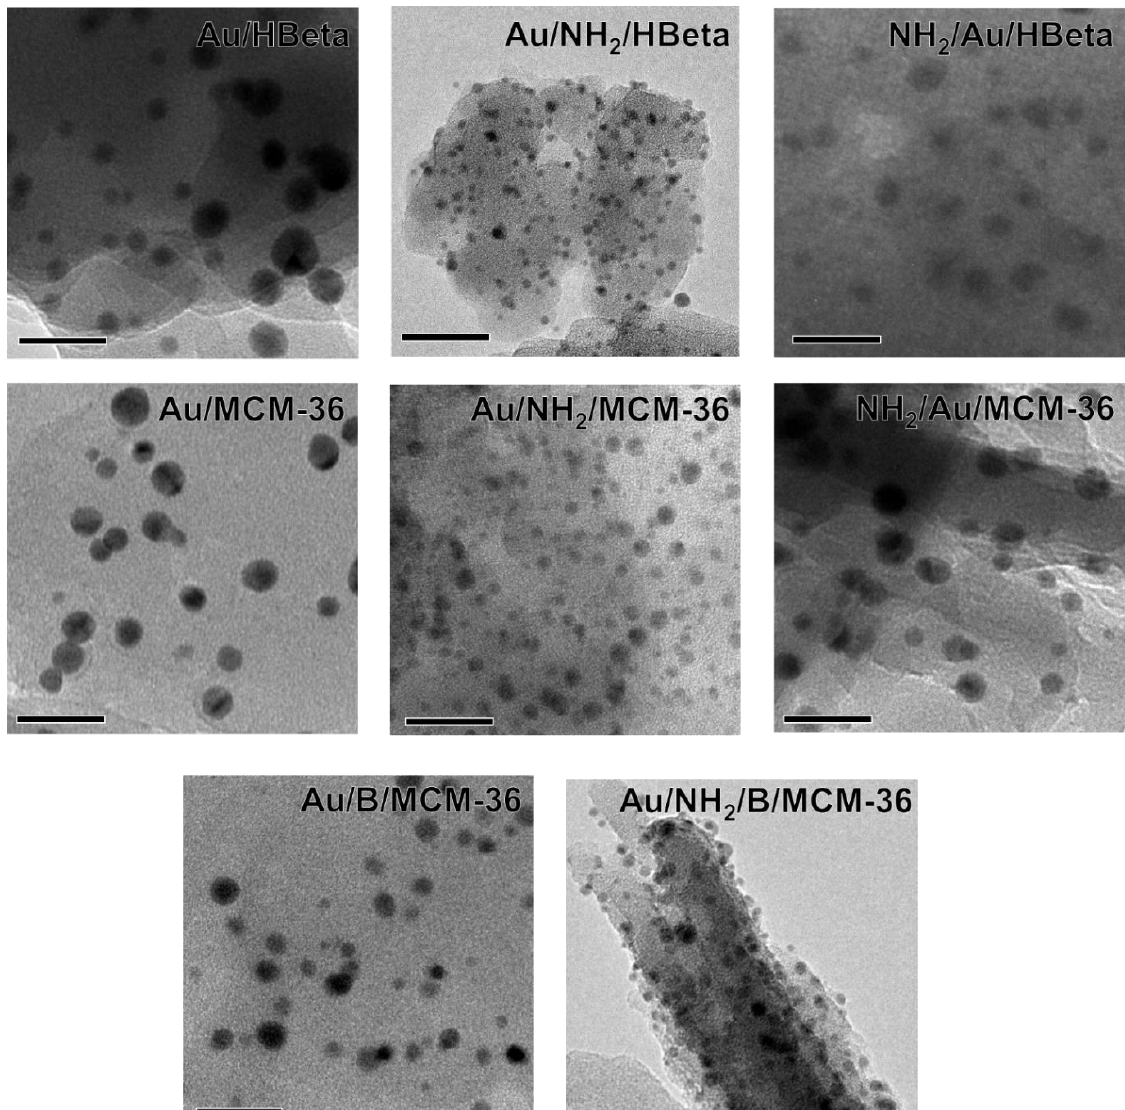
Figure 2. HR-TEM images of investigated gold catalysts. Scale bars are equal to 20 nm in each case.